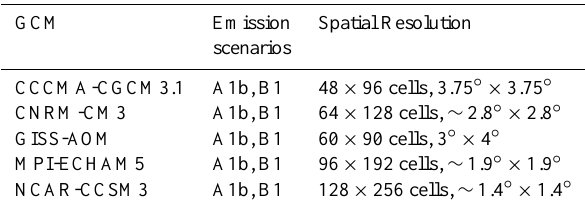
Table 2. Downscaled GCMs (general circulation models), emission scenarios used, and spatial resolution of each